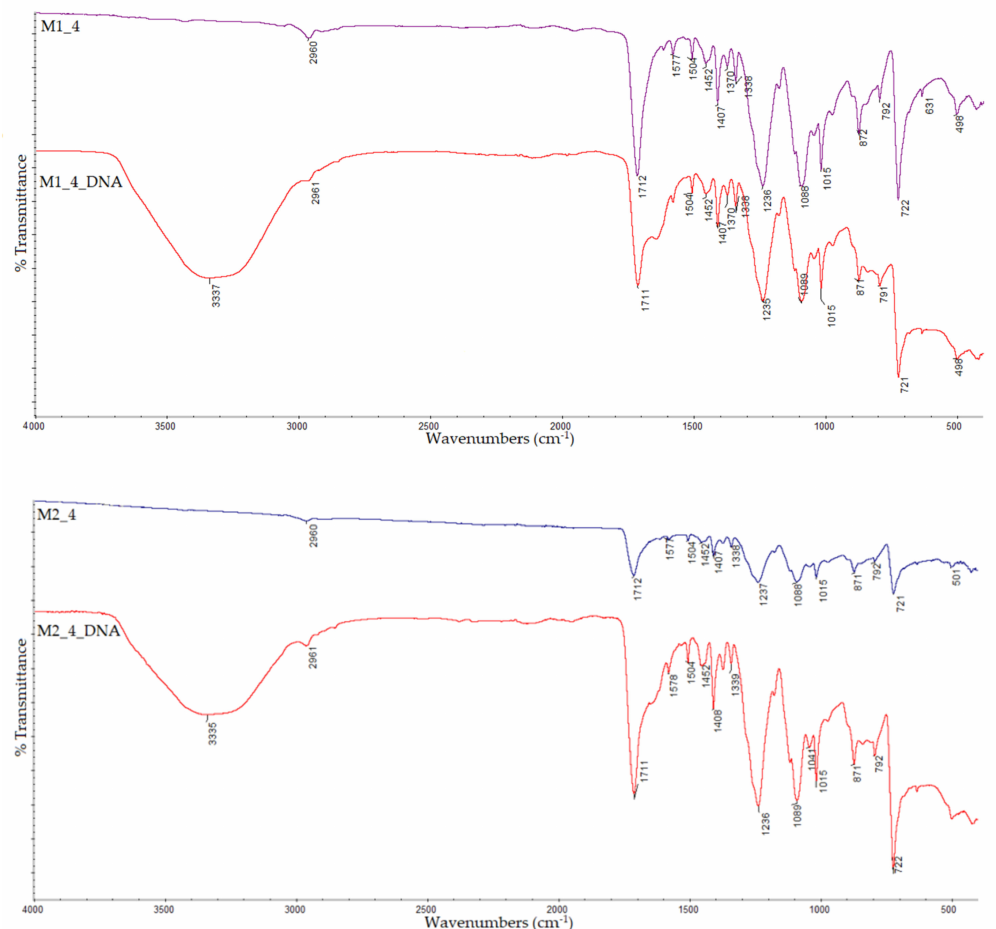
Figure 5. ATR–IR spectra of the bare PET sample (M1_4), Al nanopowder PET sample (M2_4), and DNA − contaminated samples (M1_4_DNA and M2_4_DNA).